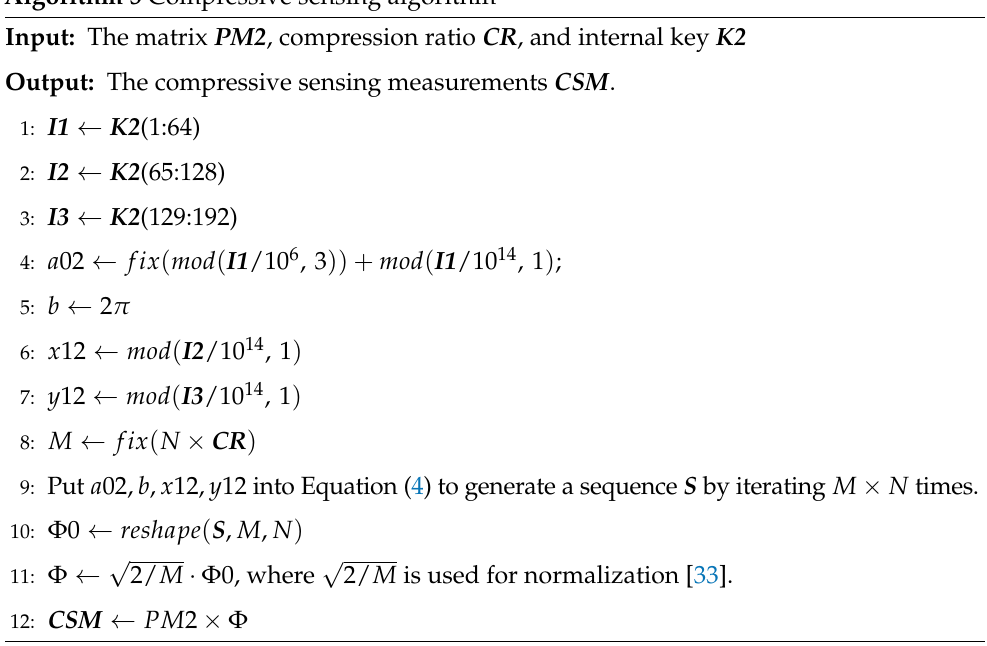
Algorithm 5 Compressive sensing